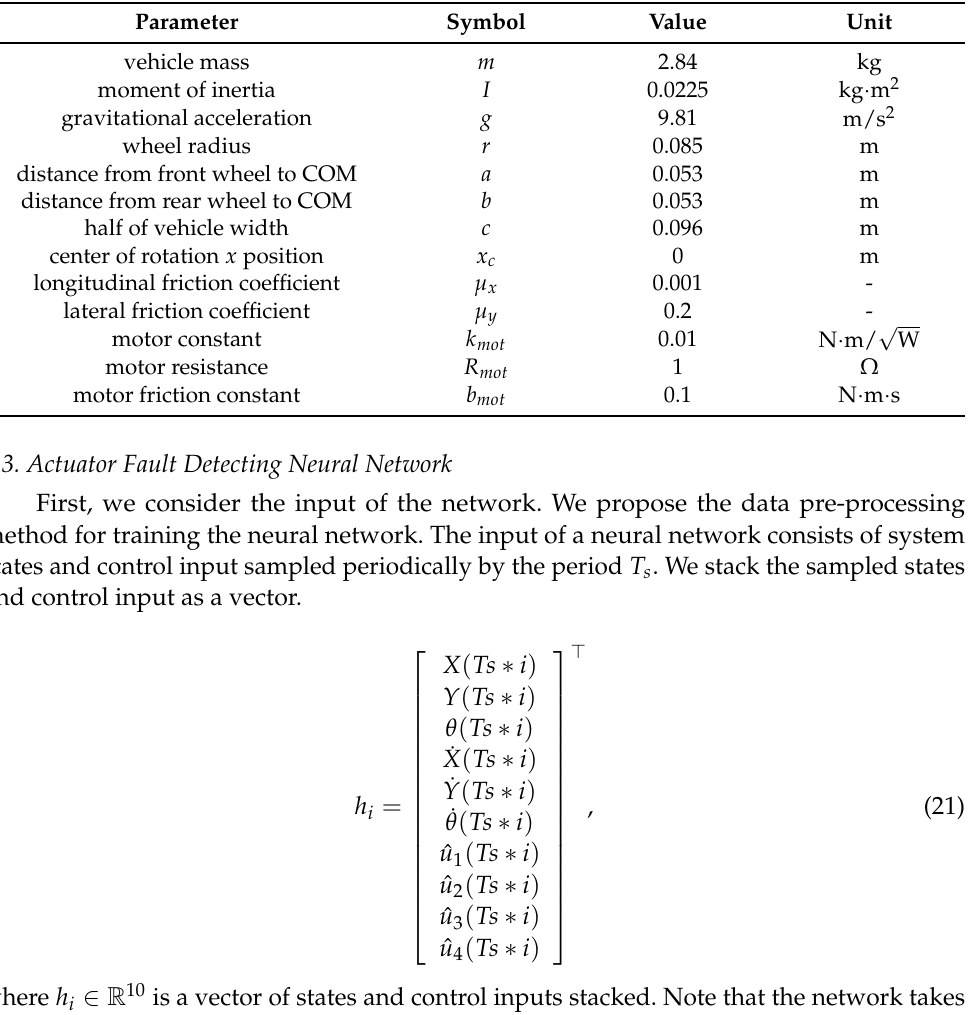
Table 1. Parameter value of